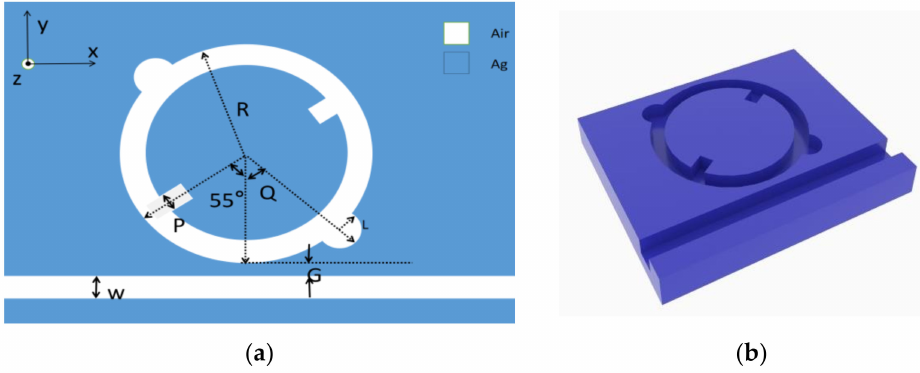
Figure 1. ( a ) Two-dimensional diagram of the DNDCC structure. ( b ) Three-dimensional diagram of the DNDCC